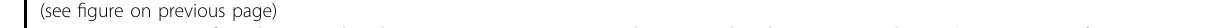
Fig. 1 PCIF1 is signi fi cantly upregulated in gastric cancer tissues and associated with poor survival. a – c The expression of PCIF1 mRNA in various human cancers was analyzed by using TCGA database. PCIF1 expression in gastric ( a ), colorectal ( b ), and liver cancers ( c ) compared to their corresponding non-tumor tissues are shown. Data are presented as log 2 value of PCIF1 relative to TBP (TATA binding protein). d , e The levels of PCIF1 mRNA in gastric cancer tissues and their adjacent non-tumor tissues from cohort Zhejiang was detected by quantitative RT-PCR. The expression pattern of PCIF1 mRNA in gastric cancer tissues from patients with different tumor stages is shown. Data are expressed as log 2 value of PCIF1 relative to GAPDH . f Immunohistochemistry analysis of gastric cancer tissue array probed with anti-PCIF1 antibody. Representative images from gastric cancer patients with different tumor stages (cohort tissue array) are presented. Immunohistochemistry scores were also analyzed. Scale bars, 200 μ m. g LC- MS/MS quanti fi cation of the m 6 Am/U ratios of mRNAs from gastric cancer tissues and their adjacent non-tumor tissues. h LC-MS/MS quanti fi cation of the m 6 Am/U ratios of total RNAs from gastric cancer tissues and their corresponding non-tumor tissues. i Kaplan – Meier survival curves of PCIF1 mRNA expression in gastric cancer tissues from cohort Zhejiang with best cutoff. j Multivariable risk factor analyses of cohort Zhejiang. All the bars correspond to 95% con fi dence intervals (CI). HR hazard rate, AJCC American Joint Committee on Cancer. k Comparison of predictive values in gastric cancer patients based on PCIF1 mRNA levels, AJCC stages, and their combination by ROC analysis in cohort Zhejiang. l Kaplan – Meier survival curves of PCIF1 protein expression in cohort tissue array with best cutoff. m Multivariable risk factor analyses of cohort tissue array. All the bars correspond to 95% CI. HR hazard rate. n Comparison of predictive values in gastric cancer patients based on PCIF1 levels, AJCC stages, and their combination by ROC analysis in cohort tissue array. Data are shown as means ± SD. * P < 0.05; ** P < 0.01, ** *P < 0.001; Mann – Whitney test ( a – c , e , f ), paired t -test ( d , h ), Student ’ s t- test ( g ), the log-rank test ( k , n